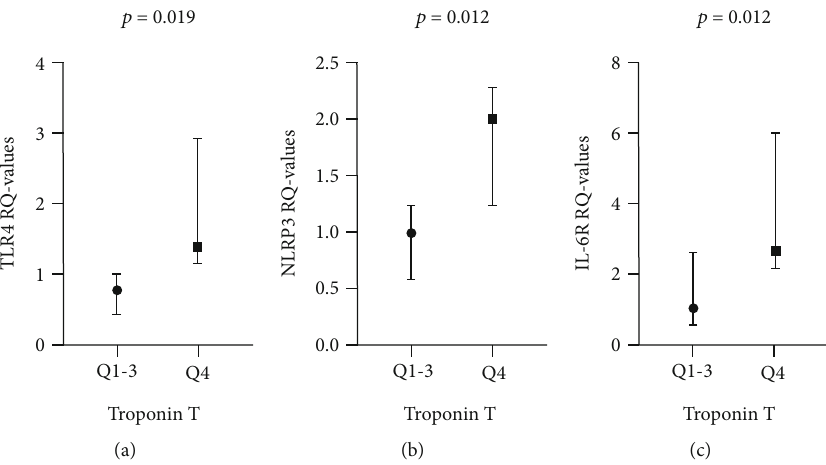
Figure 2: Genes in thrombi related to troponin T. Expression of TLR4 (a) ( n = 29 ), NLRP3 (b) ( n = 23 ), and IL-6R (c) ( n = 29 ) related to troponin T levels dichotomized between quartiles (Qs) 1-3 and Q4 (Wilcoxon rank-sum test). Dots representing medians, vertical lines between 25 th and 75 th percentiles. TLR4: Toll-like receptor 4; NLRP3: Nod-like receptor protein 3; IL-6R: Interleukin 6 receptor. Table 3: Relation to time from symptom to PCI. Spearman coe ffi cients of correlations (rho) between the markers measured at the time of PCI and time from symptom to PCI. Genes in thrombus Genes in circ.